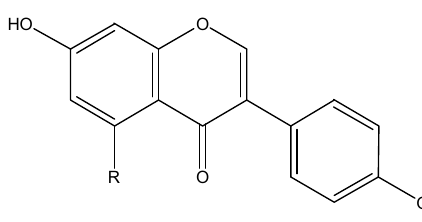
Figure 7. The chemical structures of daidzein (R = H) and genistein (R = OH).